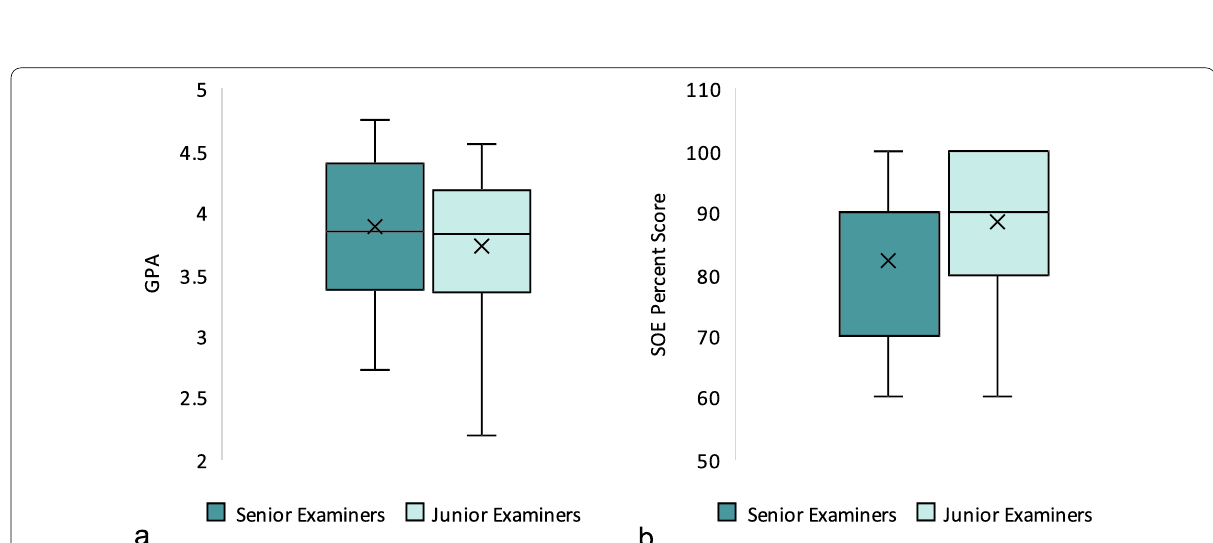
Fig. 9 Comparison of boxplots of GPAs ( a ) and SOE percent scores ( b ) between senior and junior examiners. The GPA means and the SOE percent scores means were not significantly different between the two